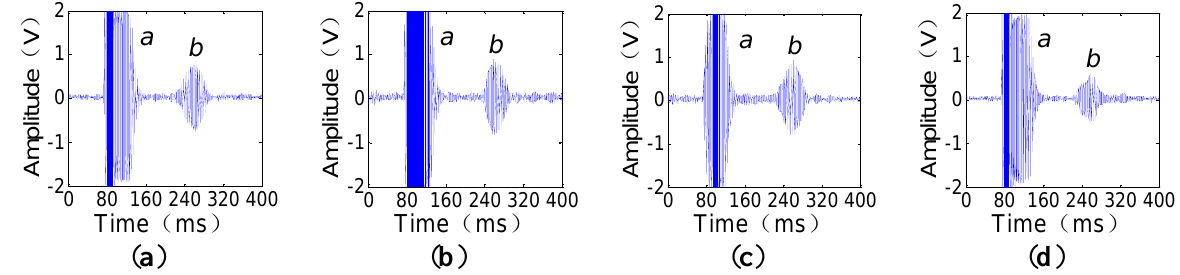
Figure 8. Detected waveforms when the receiver direction remains at 90° and the transmitter direction changes. ( a ) Transmitter direction is 30°; ( b ) Transmitter direction is 60°; ( c ) Transmitter direction is 90°; ( d ) Transmitter direction is